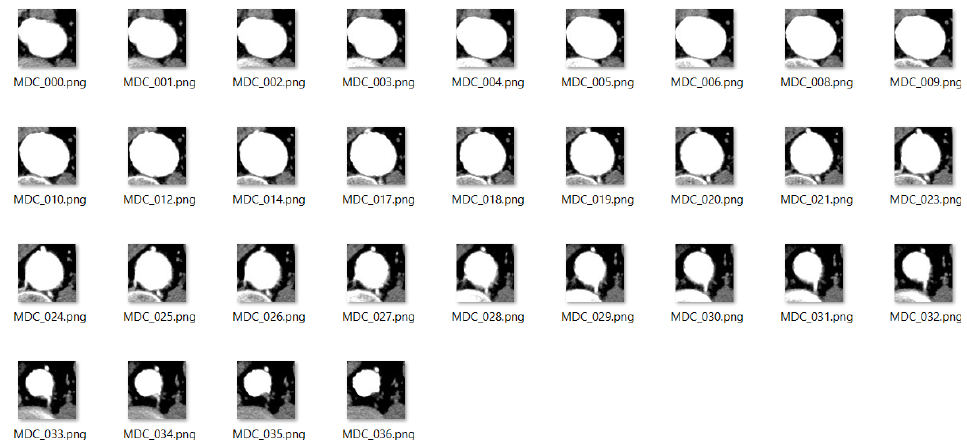
Figure 17. Sequence of images with contrast medium relating to patient ID 105.